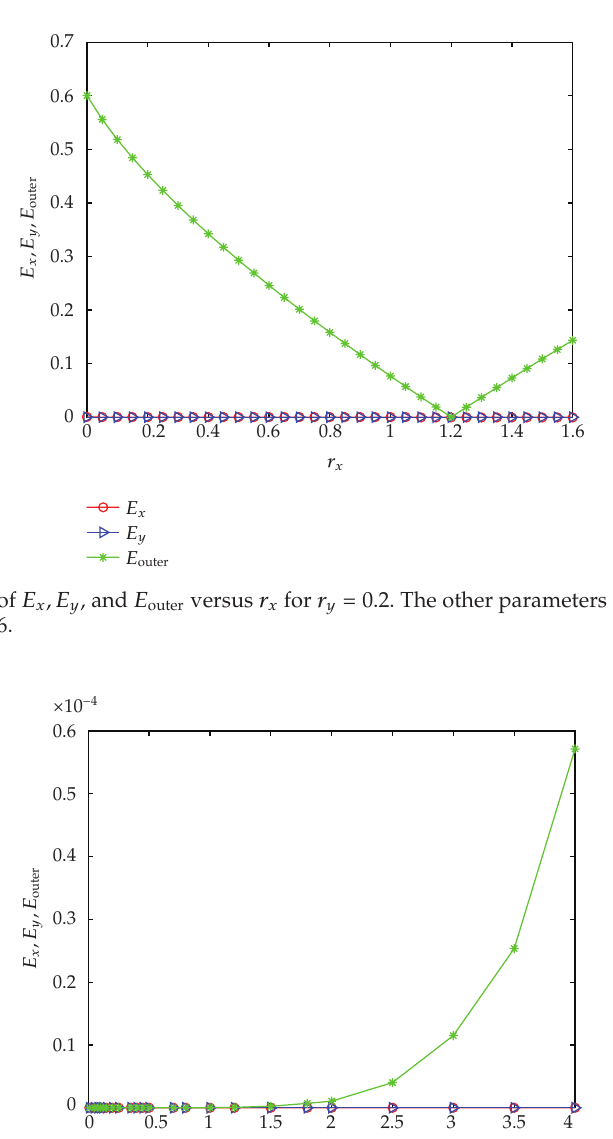
(cid:5) N C im (cid:7) 0 for all i m (cid:7) 1